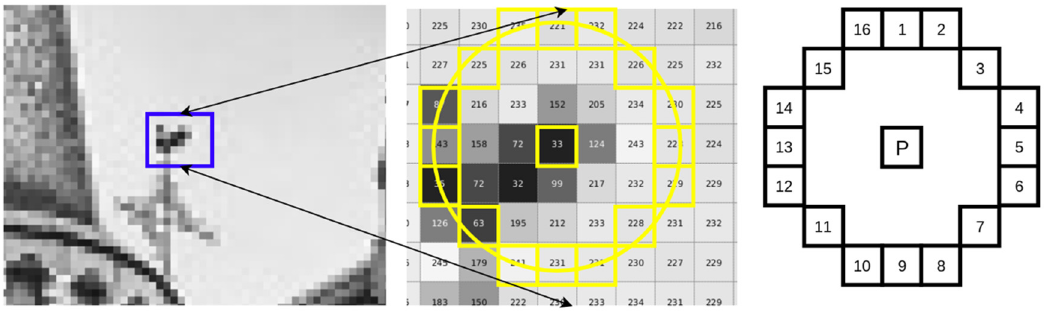
Figure 7. Example of the FAST (features from accelerated segment test) feature detector.